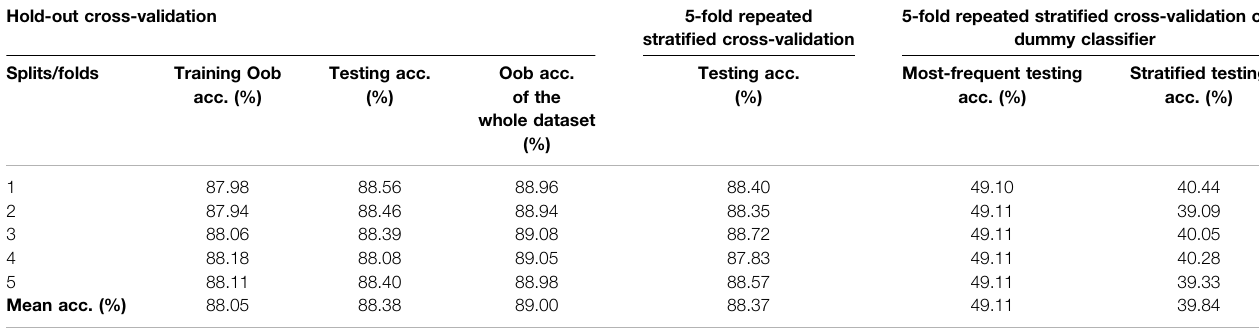
TABLE 1 | Model scoring of electrofacies recognition based on RF algorithm. Hold-out cross-validation 5-fold repeated